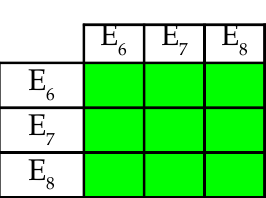
Table 15 . Analyzed theories for all the combinations of ( G; G 0 ) given by the groups E 6 , E 7 and E 8